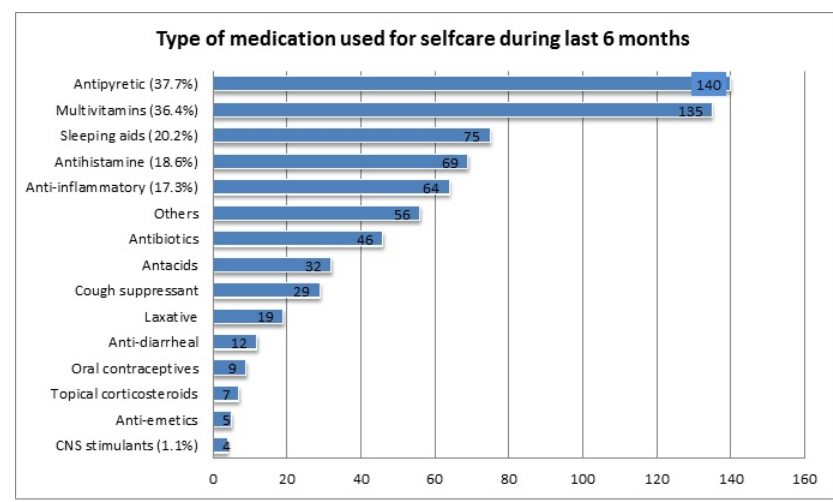
Figure 1. Type of medication used for self-care during the last six months. The participants mentioned that headache (79.2%), fever (37.7%), pain (25.9%), colds and coughs (25.3%), and menorrhea (23.2%) were the illnesses for which they sought SM (Figure 2).